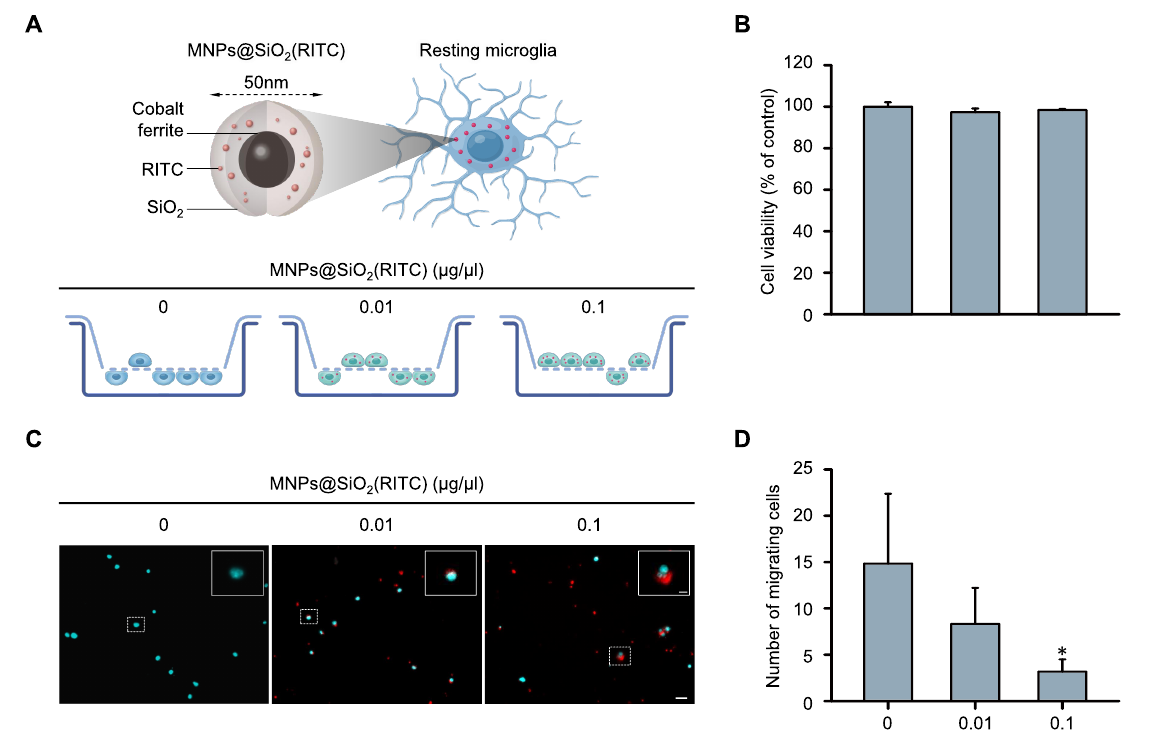
Figure 1. Reduction in migratory activity of MNPs@SiO 2 (RITC)-treated BV2 cells. ( A ) Schematic representation of the invasion assay performed with MNPs@SiO 2 (RITC)-treated BV2 cells. Non- treated control BV2 cells, 0.01 µ g/ µ L MNPs@SiO 2 (RITC)-treated BV2 cells, and 0.1 µ g/ µ L MNPs@SiO 2 (RITC)-treated BV2 cells were used. ( B ) Viability of MNPs@SiO 2 (RITC)-treated BV2 cells for 12 h. ( C ) Invasion assay of MNPs@SiO 2 (RITC)-treated BV2 cells. The nuclei of the cells were stained using Hoechst 33342, and the fluorescence was expressed as cyan. Fluorescence of MNPs@SiO 2 (RITC) distribution was expressed as red. The number of nuclei was counted in five randomly selected fields. Scale bar = 50 µ m. Scale bar of cropped image = 5 µ m. ( D ) Number of migrating cells. Data represent means ± standard deviation derived from three independent experiments. * p < 0.05 vs.